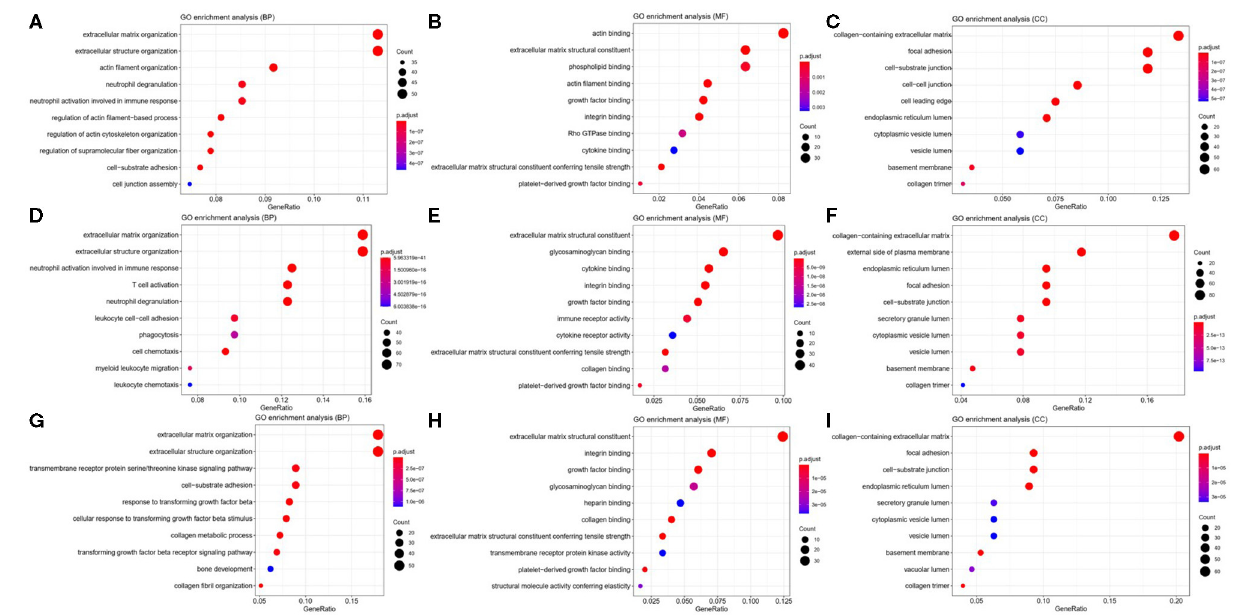
FIGURE 5 | Possible mechanisms of ITGA5 , ITGB2 , and ITGB5 involved in SSc. Top 10 significantly enriched GO terms for ITGA5 (A–C) , ITGB2 (D–F) , and ITGB5 (G–I) . The size of the circle represents gene count. Different colors of circles represent different adjusted p -value. Gene ratio means the number of genes in ITGA5 and ITGB2 / B5 co-expressed genes ( r > 0.5); genes that belong to this pathway divided by the number of genes in the background gene cluster that belong to this pathway. GO, Gene Ontology; SSc, systemic sclerosis.